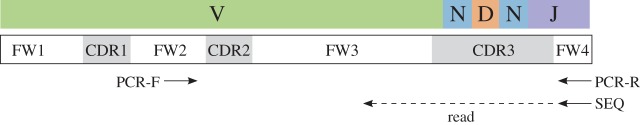
B-cell receptor schematic showing variable (V), diversity (D) and joining (J) gene segments as well as framework (FW) and complementarity-determining regions (CDRs). In VDJ recombination, individual V, D, and J gene segments are randomly selected and joined together via a process that deletes some randomly distributed number of nucleotides on their boundaries, then joins them together with random ‘non-templated insertions’ (N). The specificity of an antibody is primarily determined by the region defined by the heavy chain recombination site, referred to as the third complementarity-determining region (CDR3). The sequence data for this study started in the fourth framework (FW) region and continued into the third. Amplification was via a forward primer in the FW2 region and a reverse primer in the FW4 region.